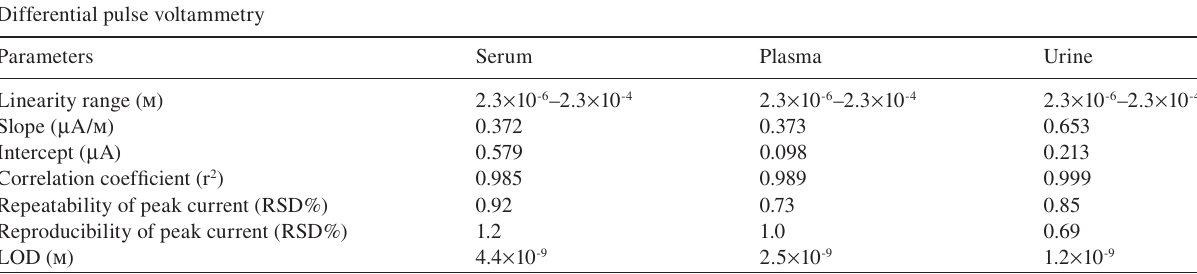
Table 3 Analytical parameters for voltammetry determination of gatifl oxacin in spiked serum, plasma and urine samples using differential pulse voltammetry.